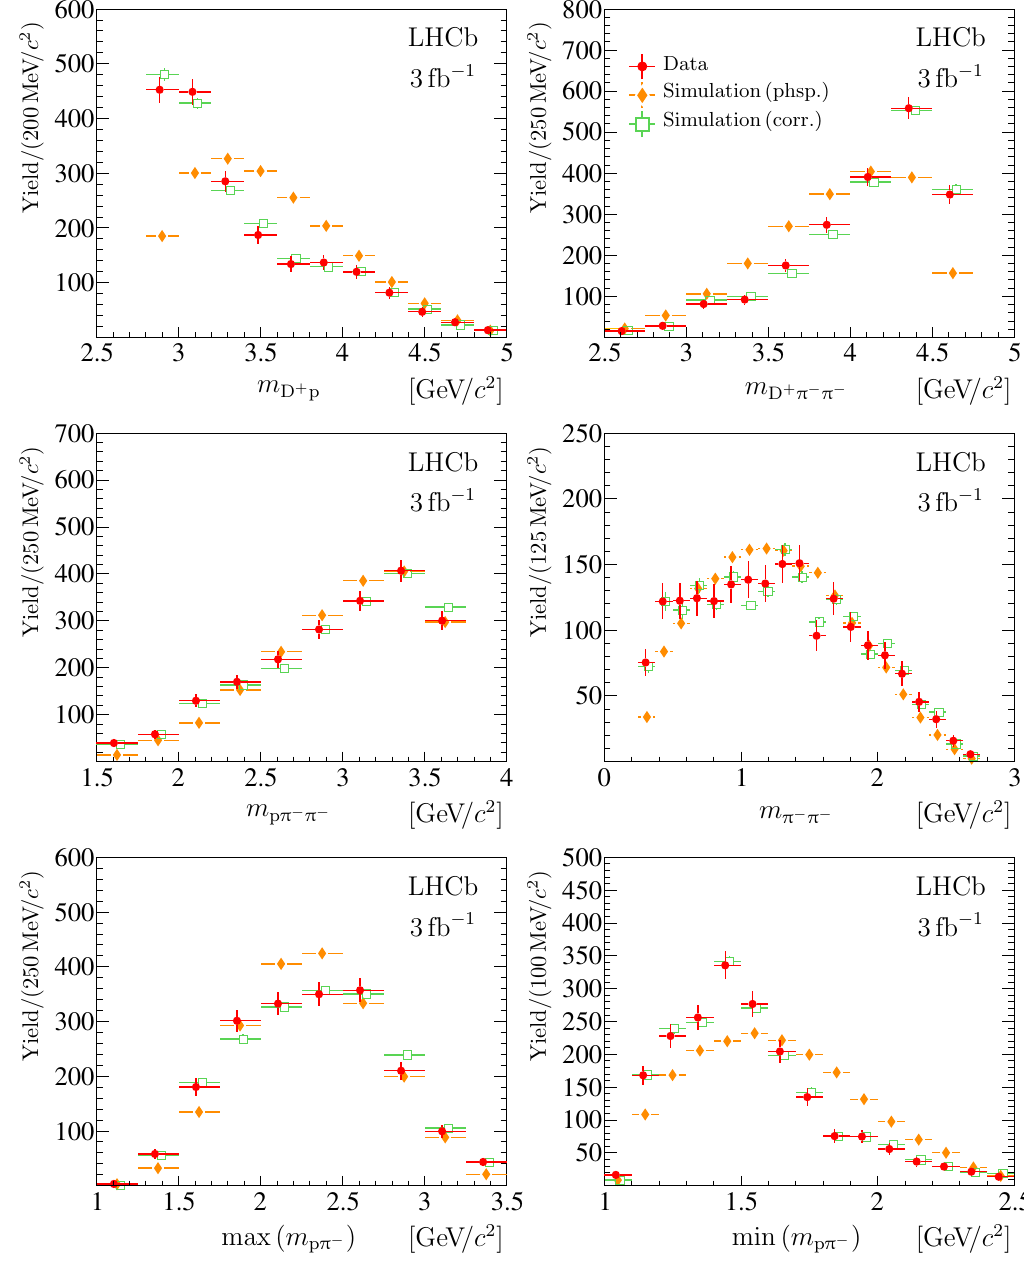
Figure 5 . Background-subtracted D + p , D + π − π − , pπ − π − , π − π − , and maximum and minimum pπ − mass spectra for Λ 0 → D + pπ − π − decays. Expectations from phase-space (phsp.) and cor- b rected (corr.) simulation are